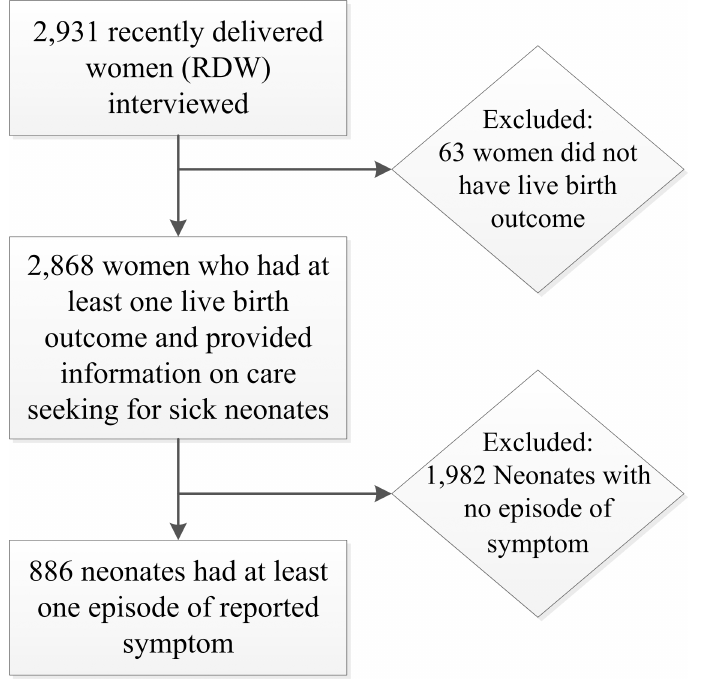
Fig 1. Selection of sample for